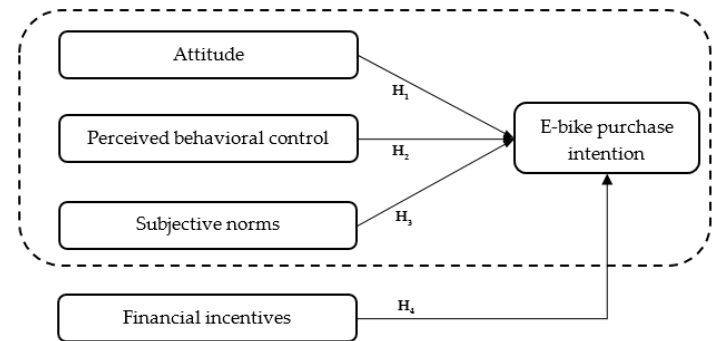
Figure 1. Conceptual